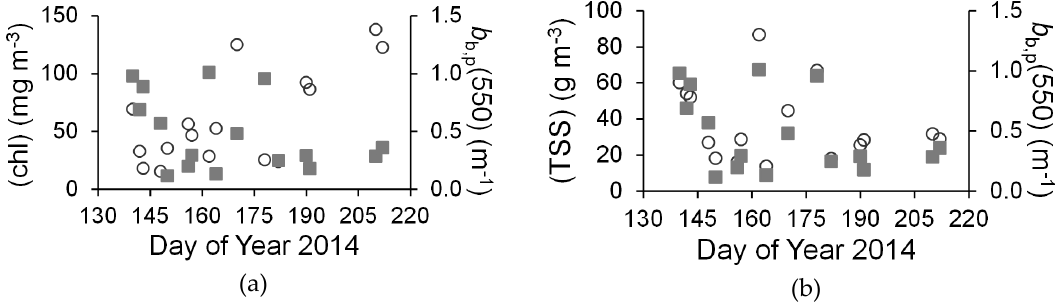
Figure 8. Variability of the retrieved backscattering coefficients of particles at 550 nm ( b b,p (550), filled squares) with measured ( a ) concentrations of total suspended sediments ((TSS)) (circles) and ( b ) concentrations of chlorophyll ((chl)) (circles) in the Wabash River and the Tippecanoe River.